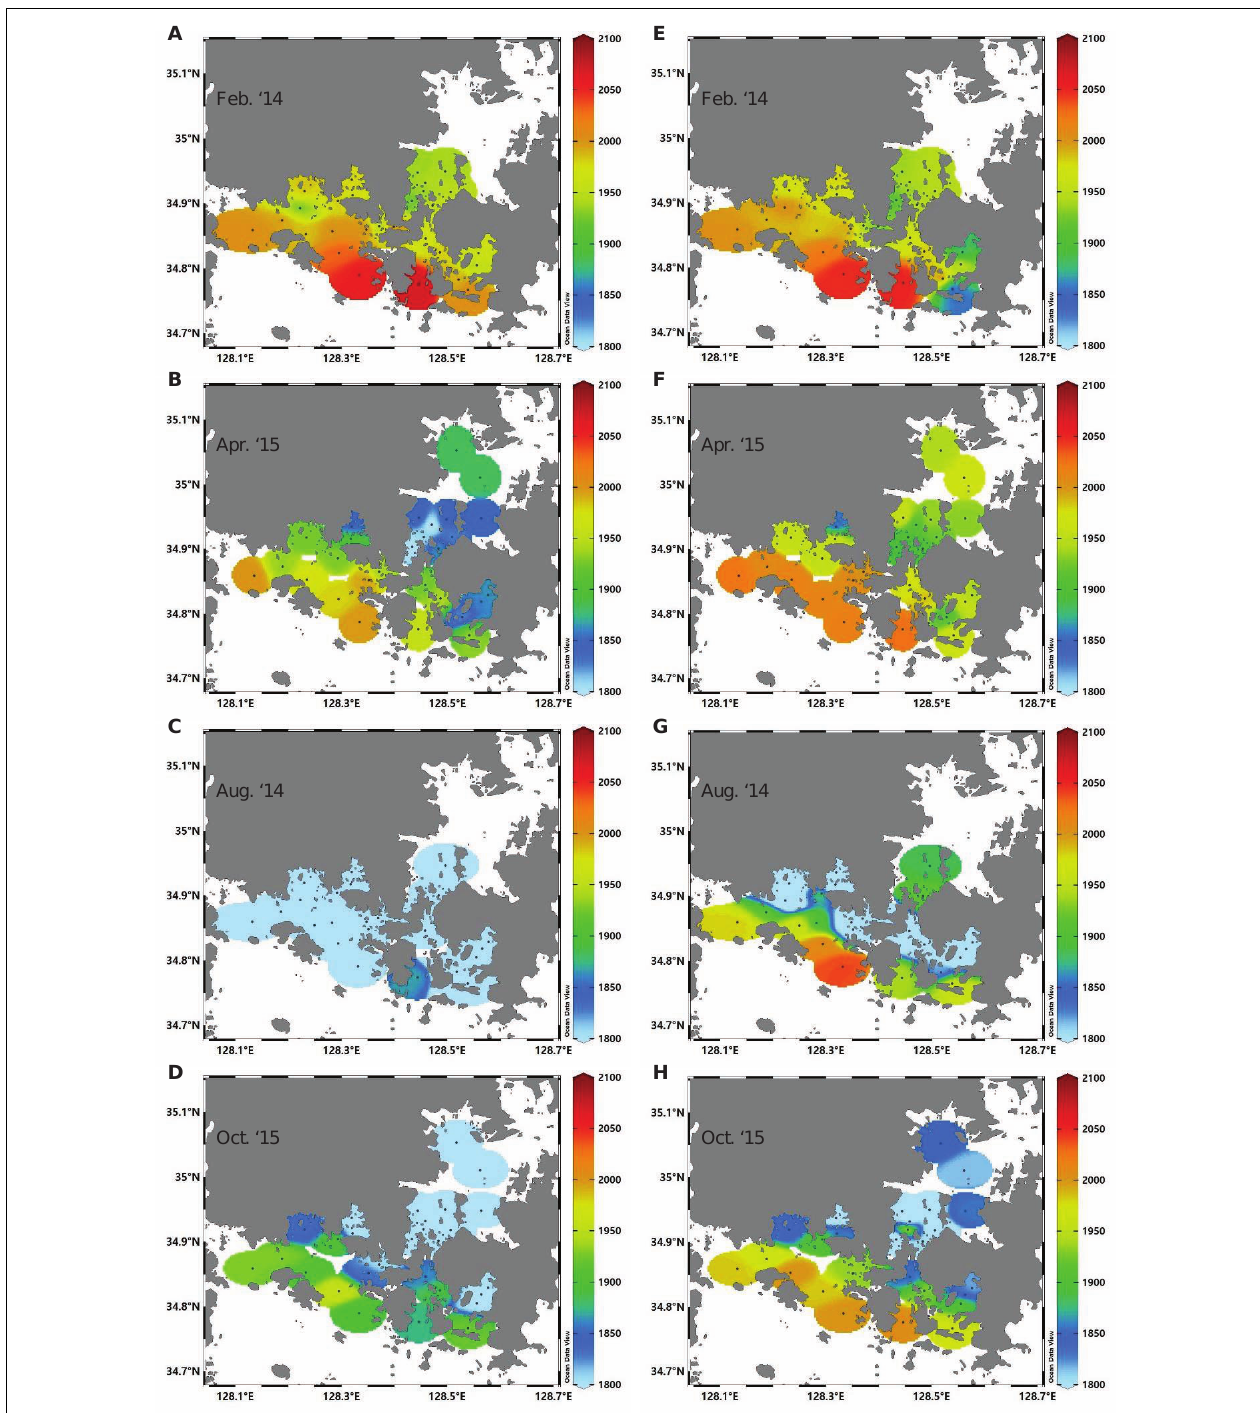
FIGURE 5 | Distributions of dissolved inorganic carbon (DIC) ( µ mol kg − 1 ) in surface water (A–D) and bottom water (E–H) for each survey.